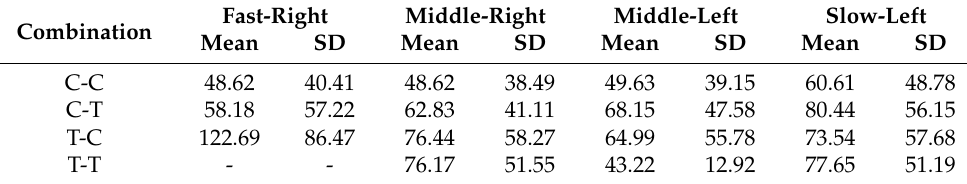
Table A5. The mean and standard deviation of ∆ D of m and n1.